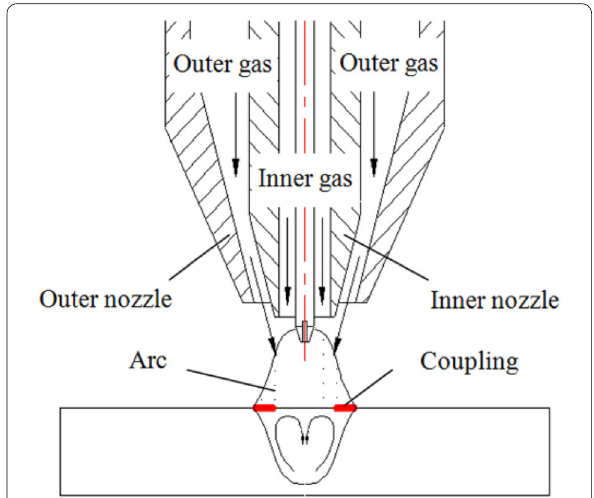
Figure 1 Schematic of GPCA‑TIG welding with coupling arc electrode